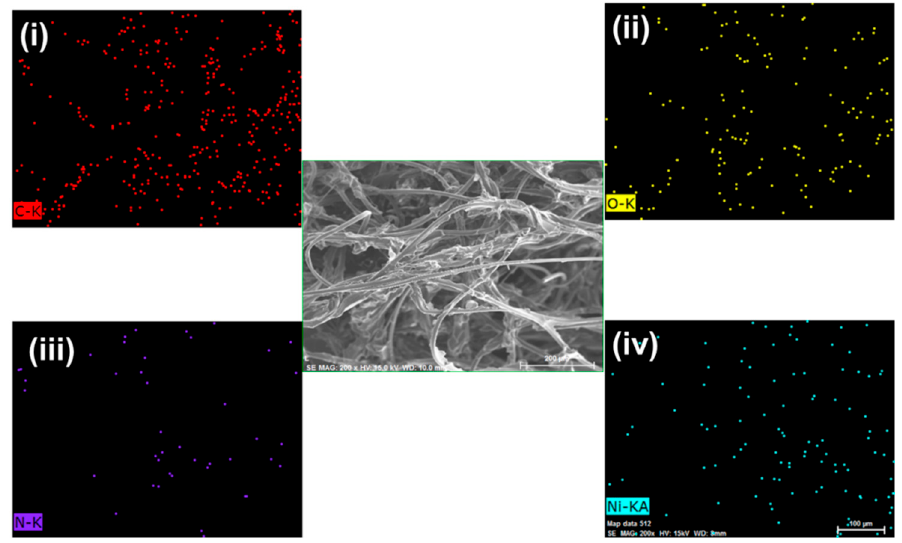
Figure 3. SEM image of Ni 2+ adsorbed gauze@PEI 0.4 /PEGDE 1 /TETA 0.6 , and ( i ) C, ( ii ) O, ( iii ) N, and ( iv ) Ni 2+ mapping.